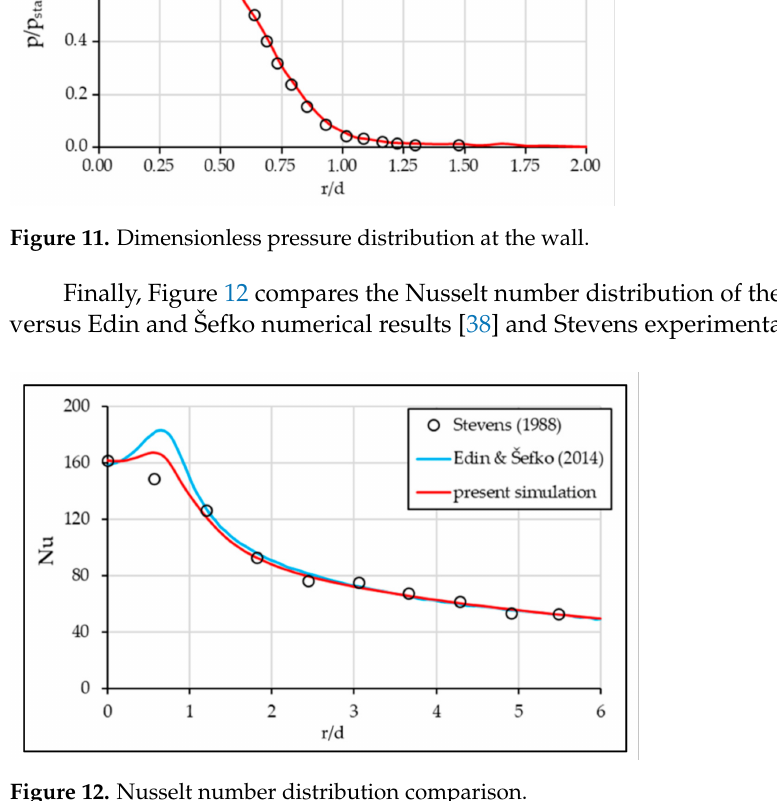
Figure 12. Nusselt number distribution